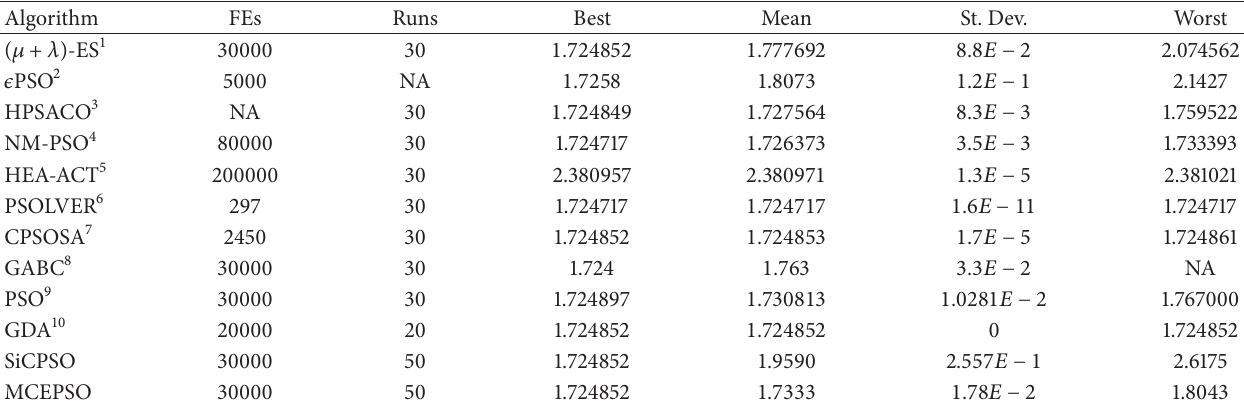
Table 3: Results for E01: welded beam design.